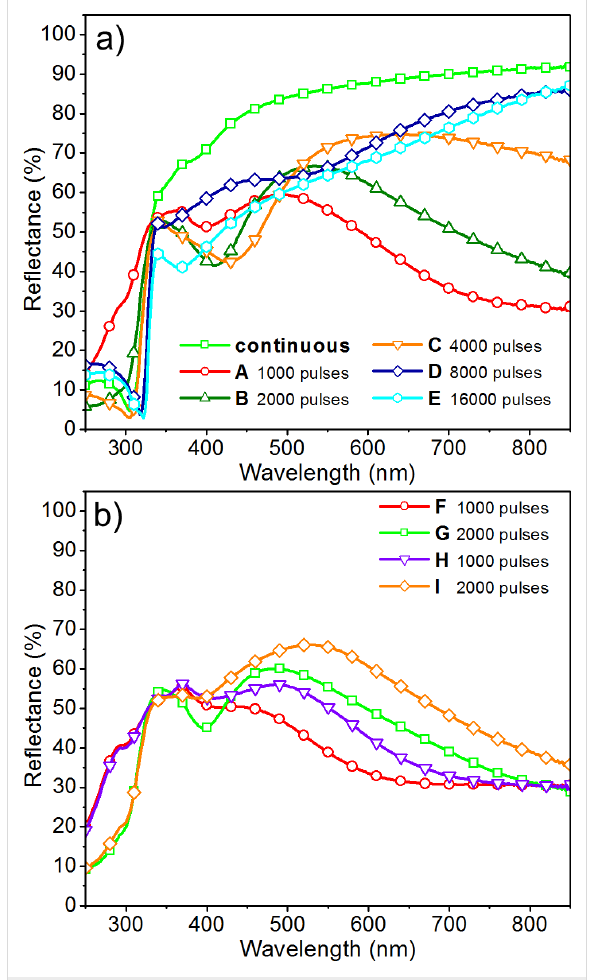
Figure 5: Reflectance spectra of fabricated Ag nanoisland films: a) for samples with the layers deposited at a laser fluence of 5.56 ± 0.37J/cm 2 , b) for samples with the layers deposited at a laser fluence of 2.52 ± 0.37J/cm 2